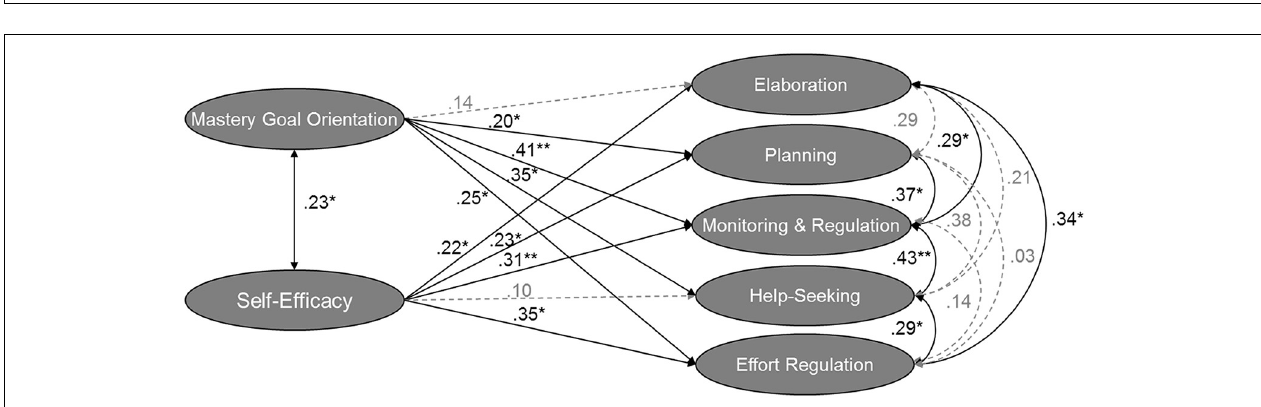
FIGURE 1 | Structural equation model showing the relations of mastery-approach goal orientation and self-efficacy to SRL strategies. Coefficient is significant at the 0.05 level *, at the 0.01 level **. Paths which are n.s. are gray colored. N = 170. The model fit is χ 2 (342) = 400.801, CFI = 0.939, RMSEA (90% CI) = 0.032 [0.016; 0.044], SRMR = 0.064.